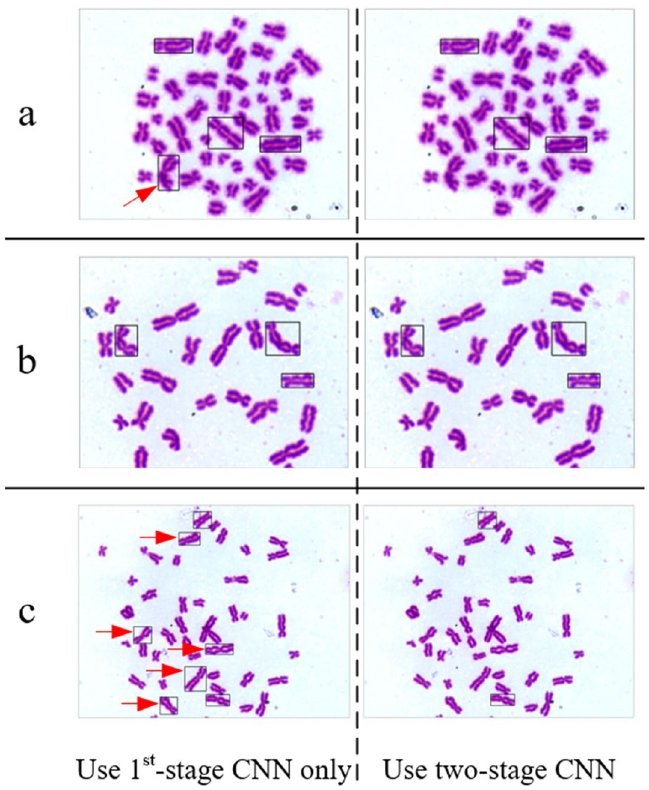
Figure 13. Identification results of two automatic identification modes for three kinds of typical chromosome. ( a ) Image with long arms entangled chromosome, ( b ) image with tricentric chromosome, ( c ) image with DIC.